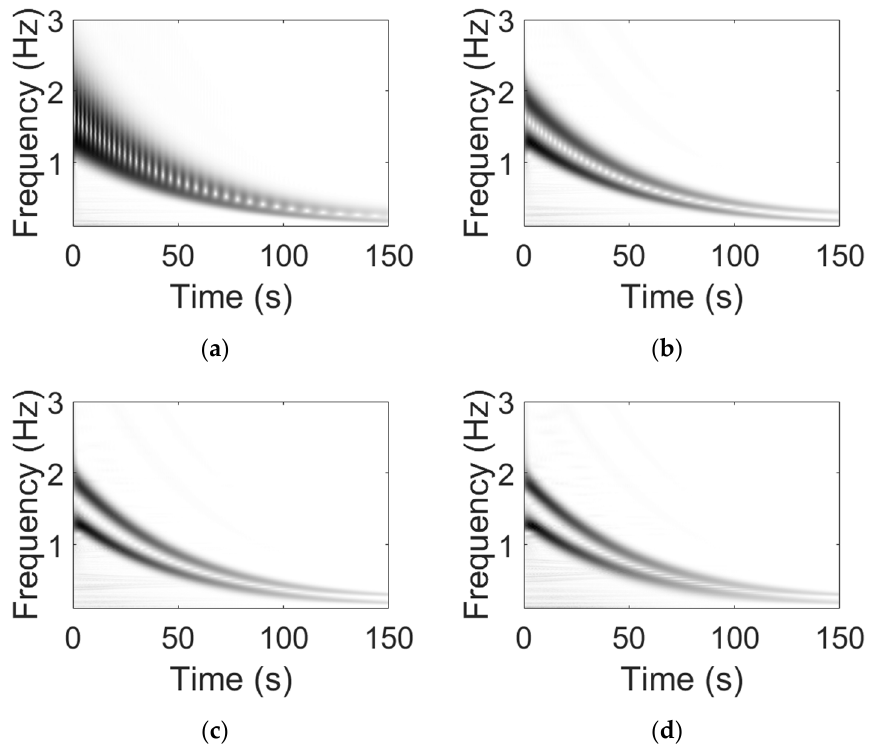
Figure 3. Wavelet transforms: ( a ) center frequency of 1 Hz; ( b ) center frequency of 2 Hz; ( c ) center frequency of 3 Hz; ( d ) center frequency of 4